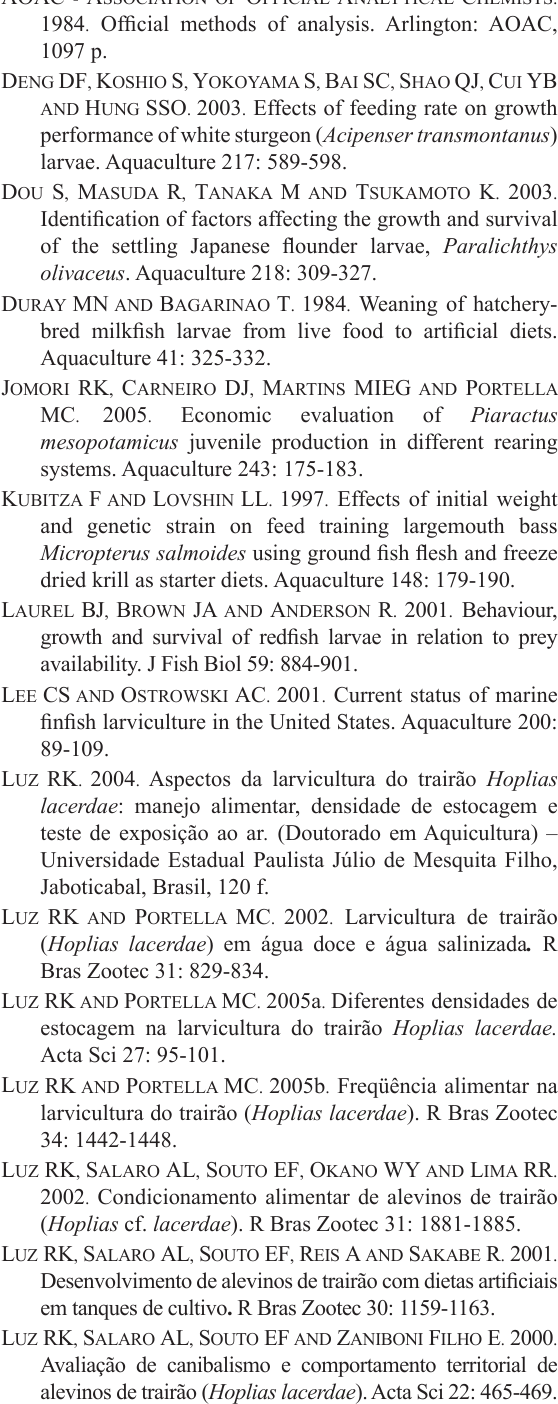
lacerdae : manejo alimentar, densidade de estocagem